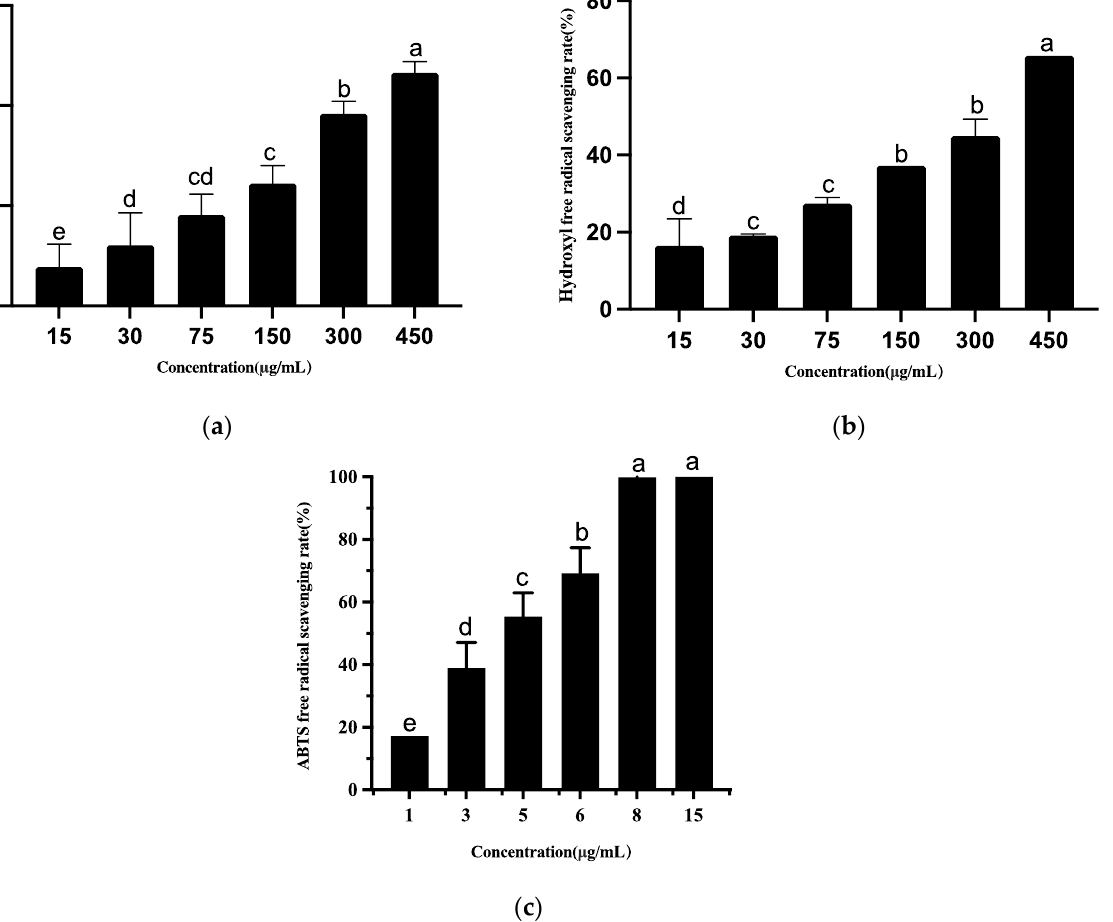
Figure 7. The antioxidant capacity of ethyl acetate extracts of B. subtilis T5. ( a ) DPPH radical scavenging activity; ( b ) Hydroxyl radical scavenging activity; ( c ) ABTS radical scavenging activity. The data were analyzed using one-way analysis of variance (ANOVA, p < 0.05). Different lowercase letters above the bars indicate significant differences ( p < 0.05).